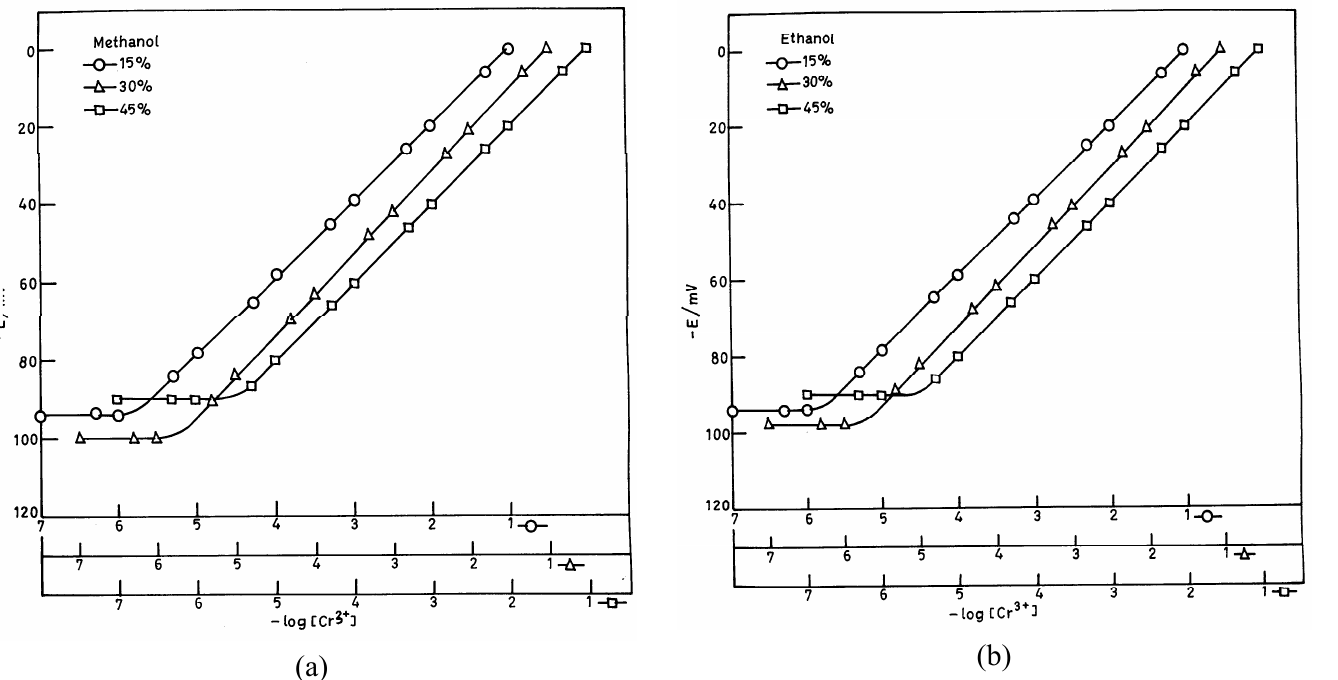
Figure 3. Plots of potential vs. log [Cr(III)] of mixed solutions: (a) water-methanol and (b) water- ethanol.